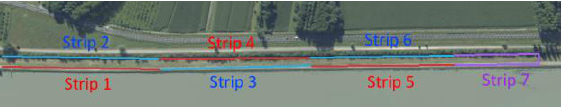
Figure 2: Dyke survey flight plan.